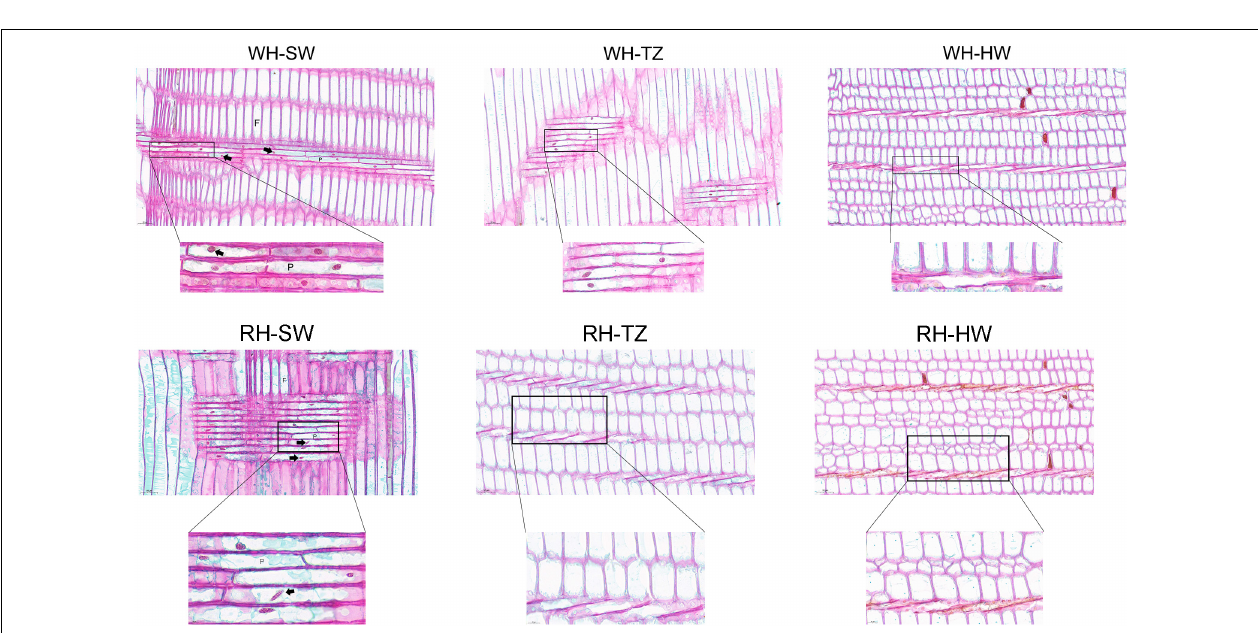
FIGURE 6 | Radial sections of ray parenchyma cells in the SW, TZ, and HW of white-heart and red-heart Chinese fir. F, fiber; P, ray parenchyma cells. The complete nucleus was indicated by the arrow.